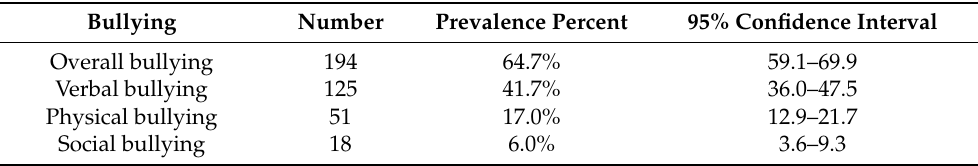
Table 1. Prevalence of bullying and concomitant 95% confidence intervals among secondary school students in Khamis Mushait city, southwestern Saudi Arabia ( n = 300). Bullying Number Prevalence Percent 95% Confidence Interval Overall bullying